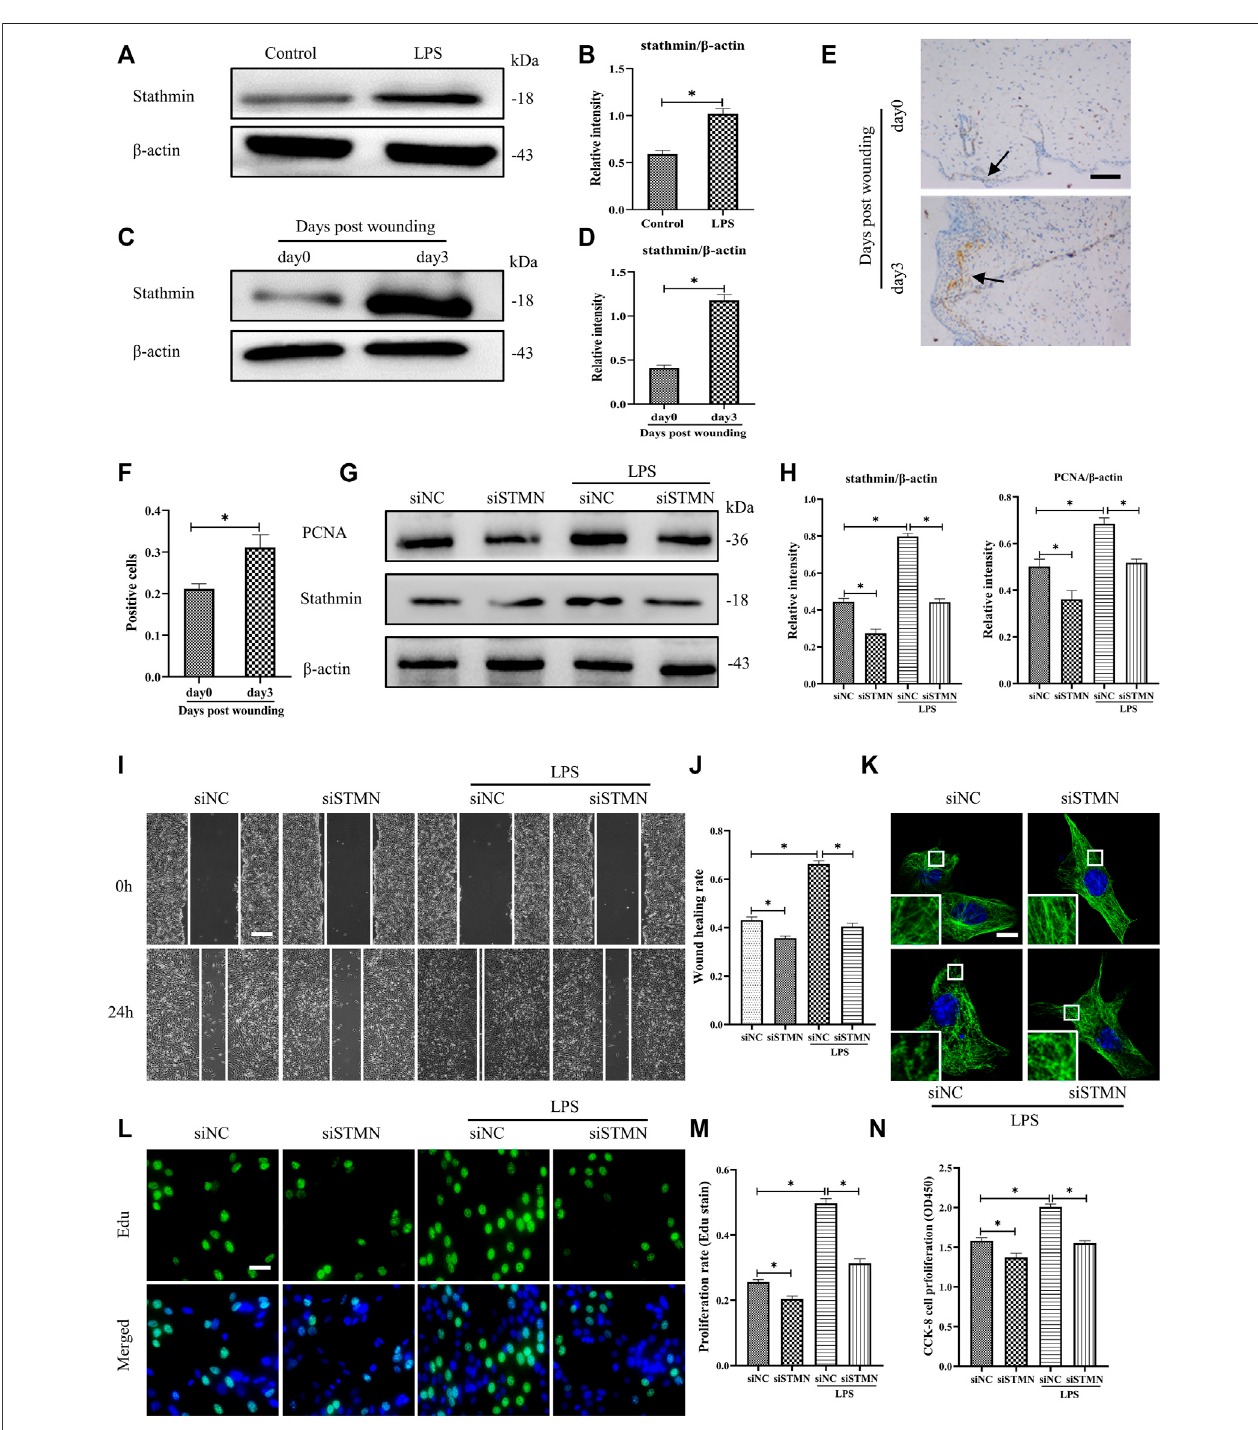
FIGURE 3 | LPS-induced stathmin expression and its effects on HDF migration and proliferation and MT depolymerization. (A) Western blotting was performed to detect stathmin expression with or without LPS, and (B) the results were quantitatively analyzed ( n (cid:1) 5). (C) Western blotting was performed to detect stathmin expression in wound edge tissue post wounding, and (D) the results were quantitatively analyzed ( n (cid:1) 5). (E) Stathmin expression at the wound edge of mice post woundingwasdetectedbyimmunohistochemicalstaining.Bar,100 μ m,thearrowpointstothepositivecells,and (F) theresultswerequantitativelyanalyzed( n (cid:1) 5). (G) Cells were transfected with siSTMN or siNC before treatment with or without LPS stimulation. Western blotting was performed to detect stathmin and PCNA expression, and (H) the results were quantitatively analyzed ( n (cid:1) 5). (I) Scratch wound healing assays were performed to detect HDF migration treated with LPS after siSTMN or siNC transfection., Bar, 200 μ m, and (J) the results were quantitatively analyzed ( n (cid:1) 5). (K) For the tubulin immuno fl uorescence images of MTs, cells were